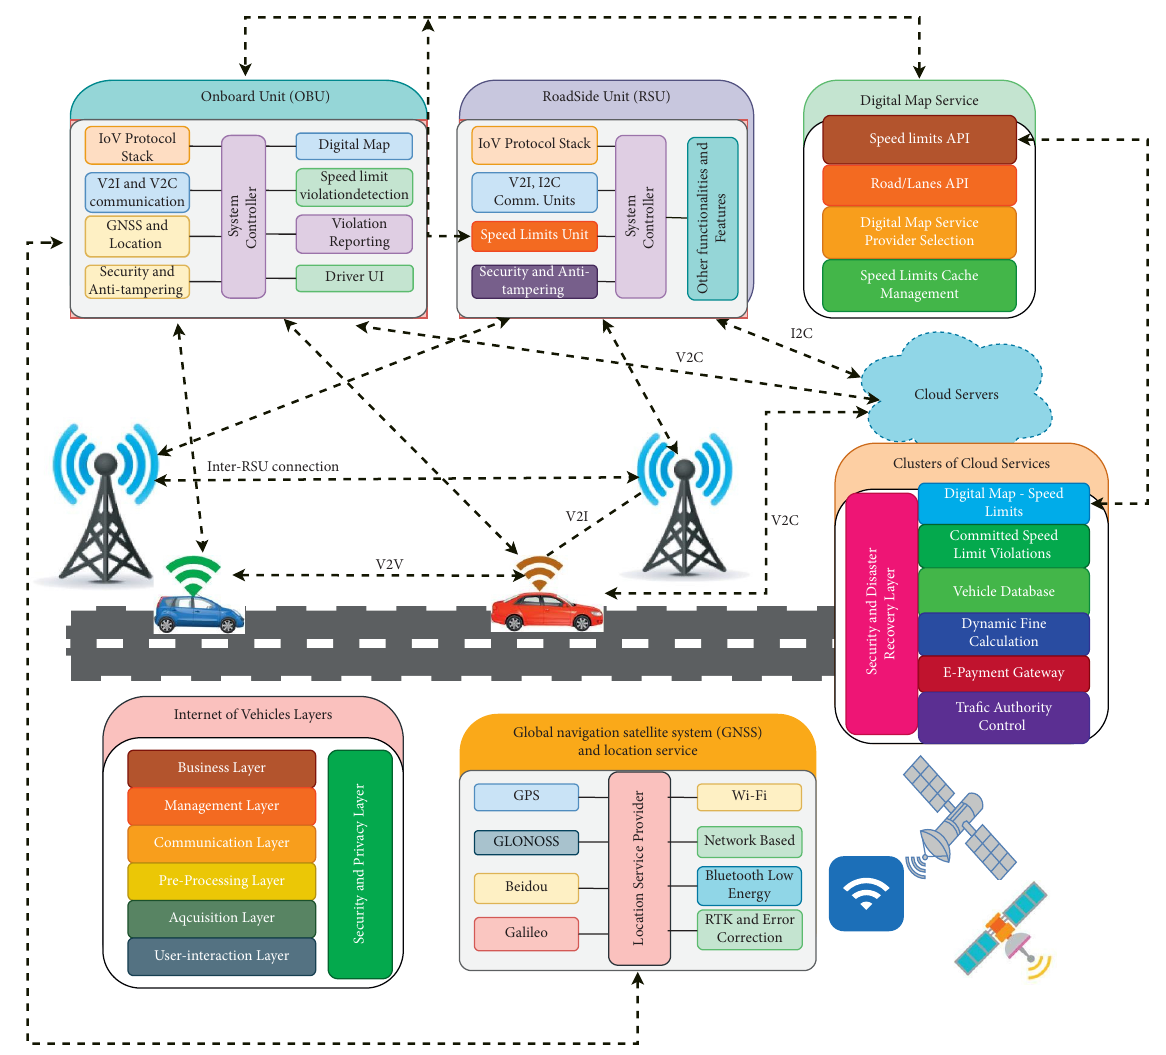
Figure 2: Overall over-/underspeed limit violation detection and reporting system based on the Internet of